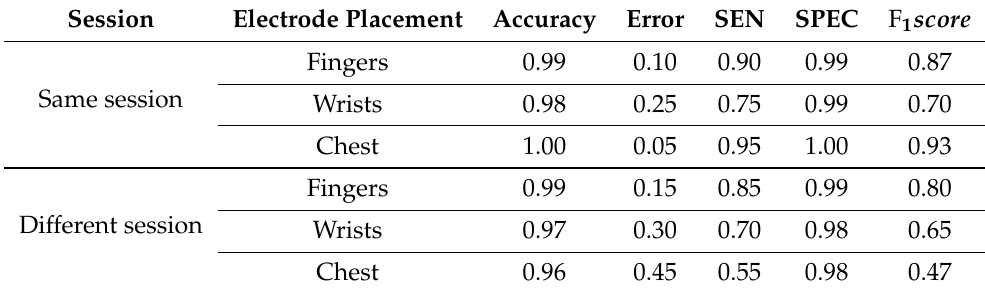
Table 2. Evaluation of accuracy, error, sensitivity, specificity and F 1 score for each electrode placement, when the method is tested and trained with segments from the same session and different sessions. Session Electrode